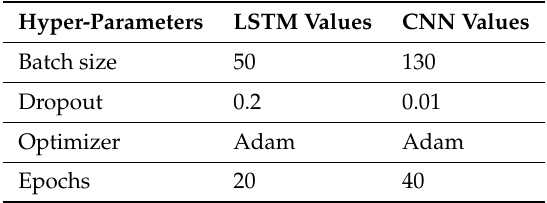
Table 8. Hyper-parameter values of CNN and